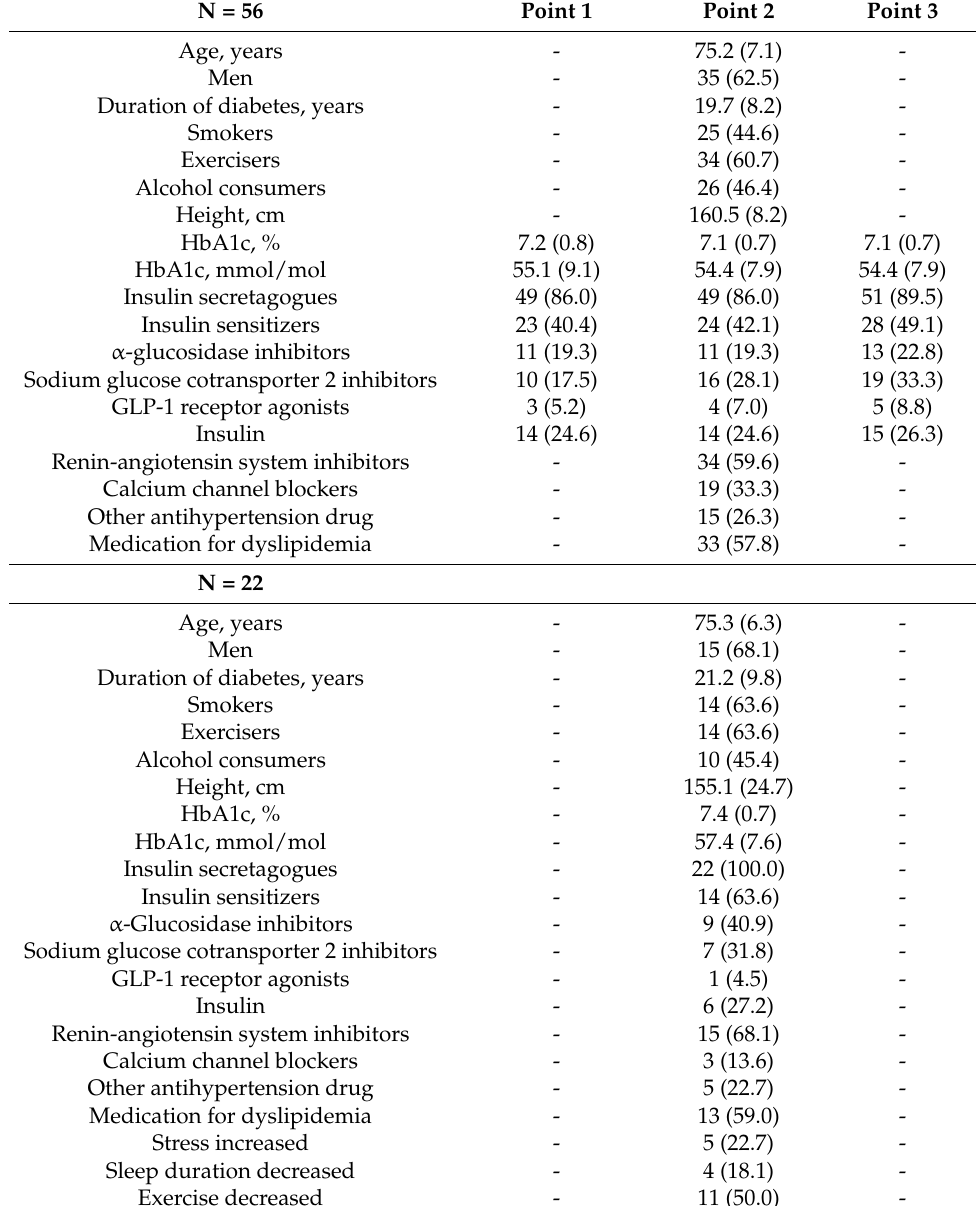
Table 1. Baseline characteristics (point 2) of study